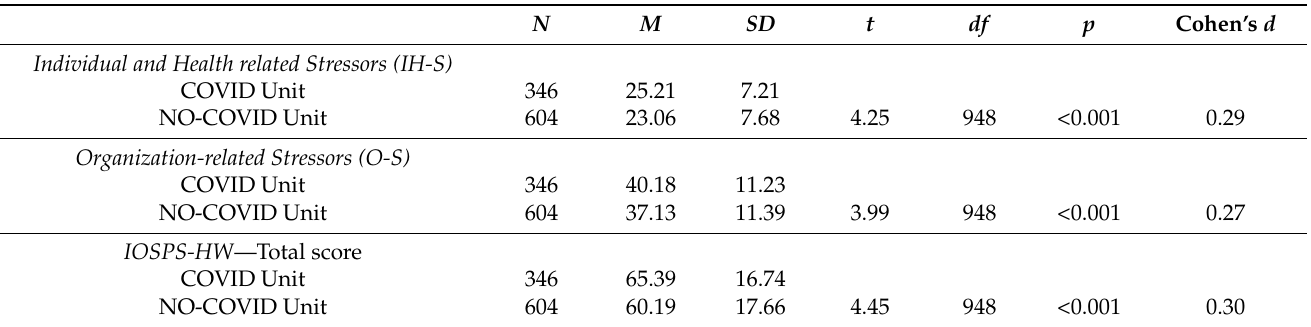
Table 4. Differences between participants who did not work in COVID Units and participants who worked/had worked in COVID Units for the Individual and Organization related Stressors in Pandemic Scale for Healthcare Workers (IOSPS-HW) subscales and total score. N M SD